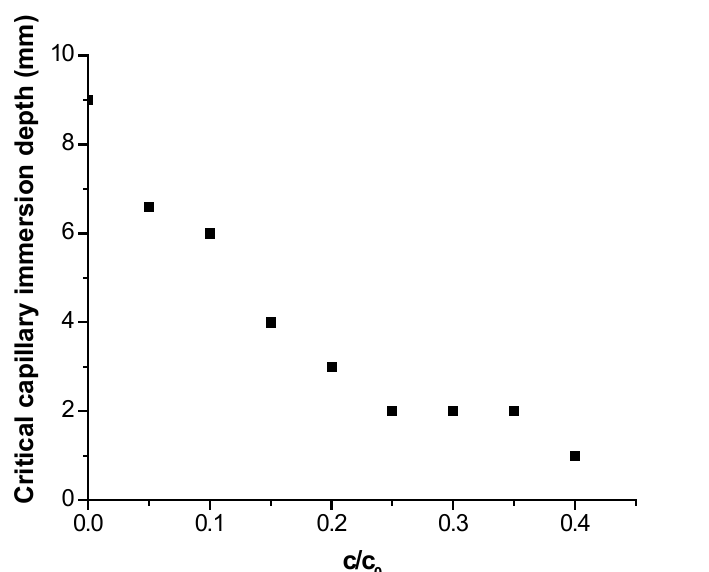
Figure 15. Dependence of the critical capillary immersion depth dividing the oscillatory regime and the regime of steady convection by the dissolution of a heptanol droplet on the initial concentration of heptanol in the liquid bulk; the vessel diameter 40 mm (reprinted from [36], with permission from Elsevier).